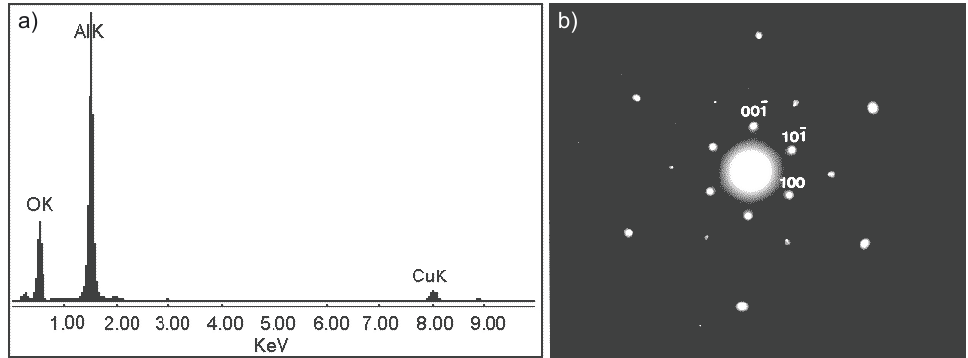
Figure 3. (a) The energy dispersive spectroscopy/transmission electron microscopy (EDS/TEM) microanalysis shows that the sheets (Fig. 2b) are composed of only aluminium and oxygen. (b) Corresponding selected area electron diffraction (SAED) shows nordstrandite